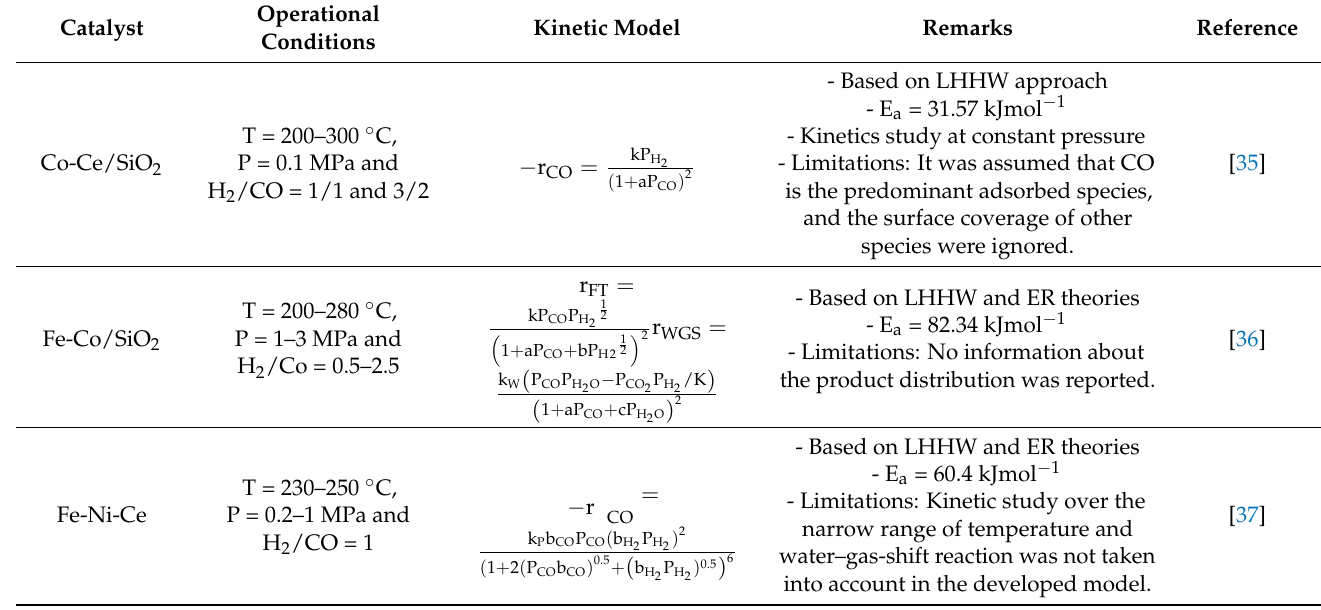
Figure 4. Flow chart of the kinetics study for FTS. Table 3. FTS kinetic models based on iron and cobalt catalysts.